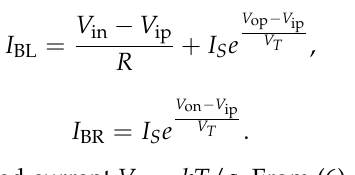
Figure 12. Using the exponential characteristic between the current and the voltage of the